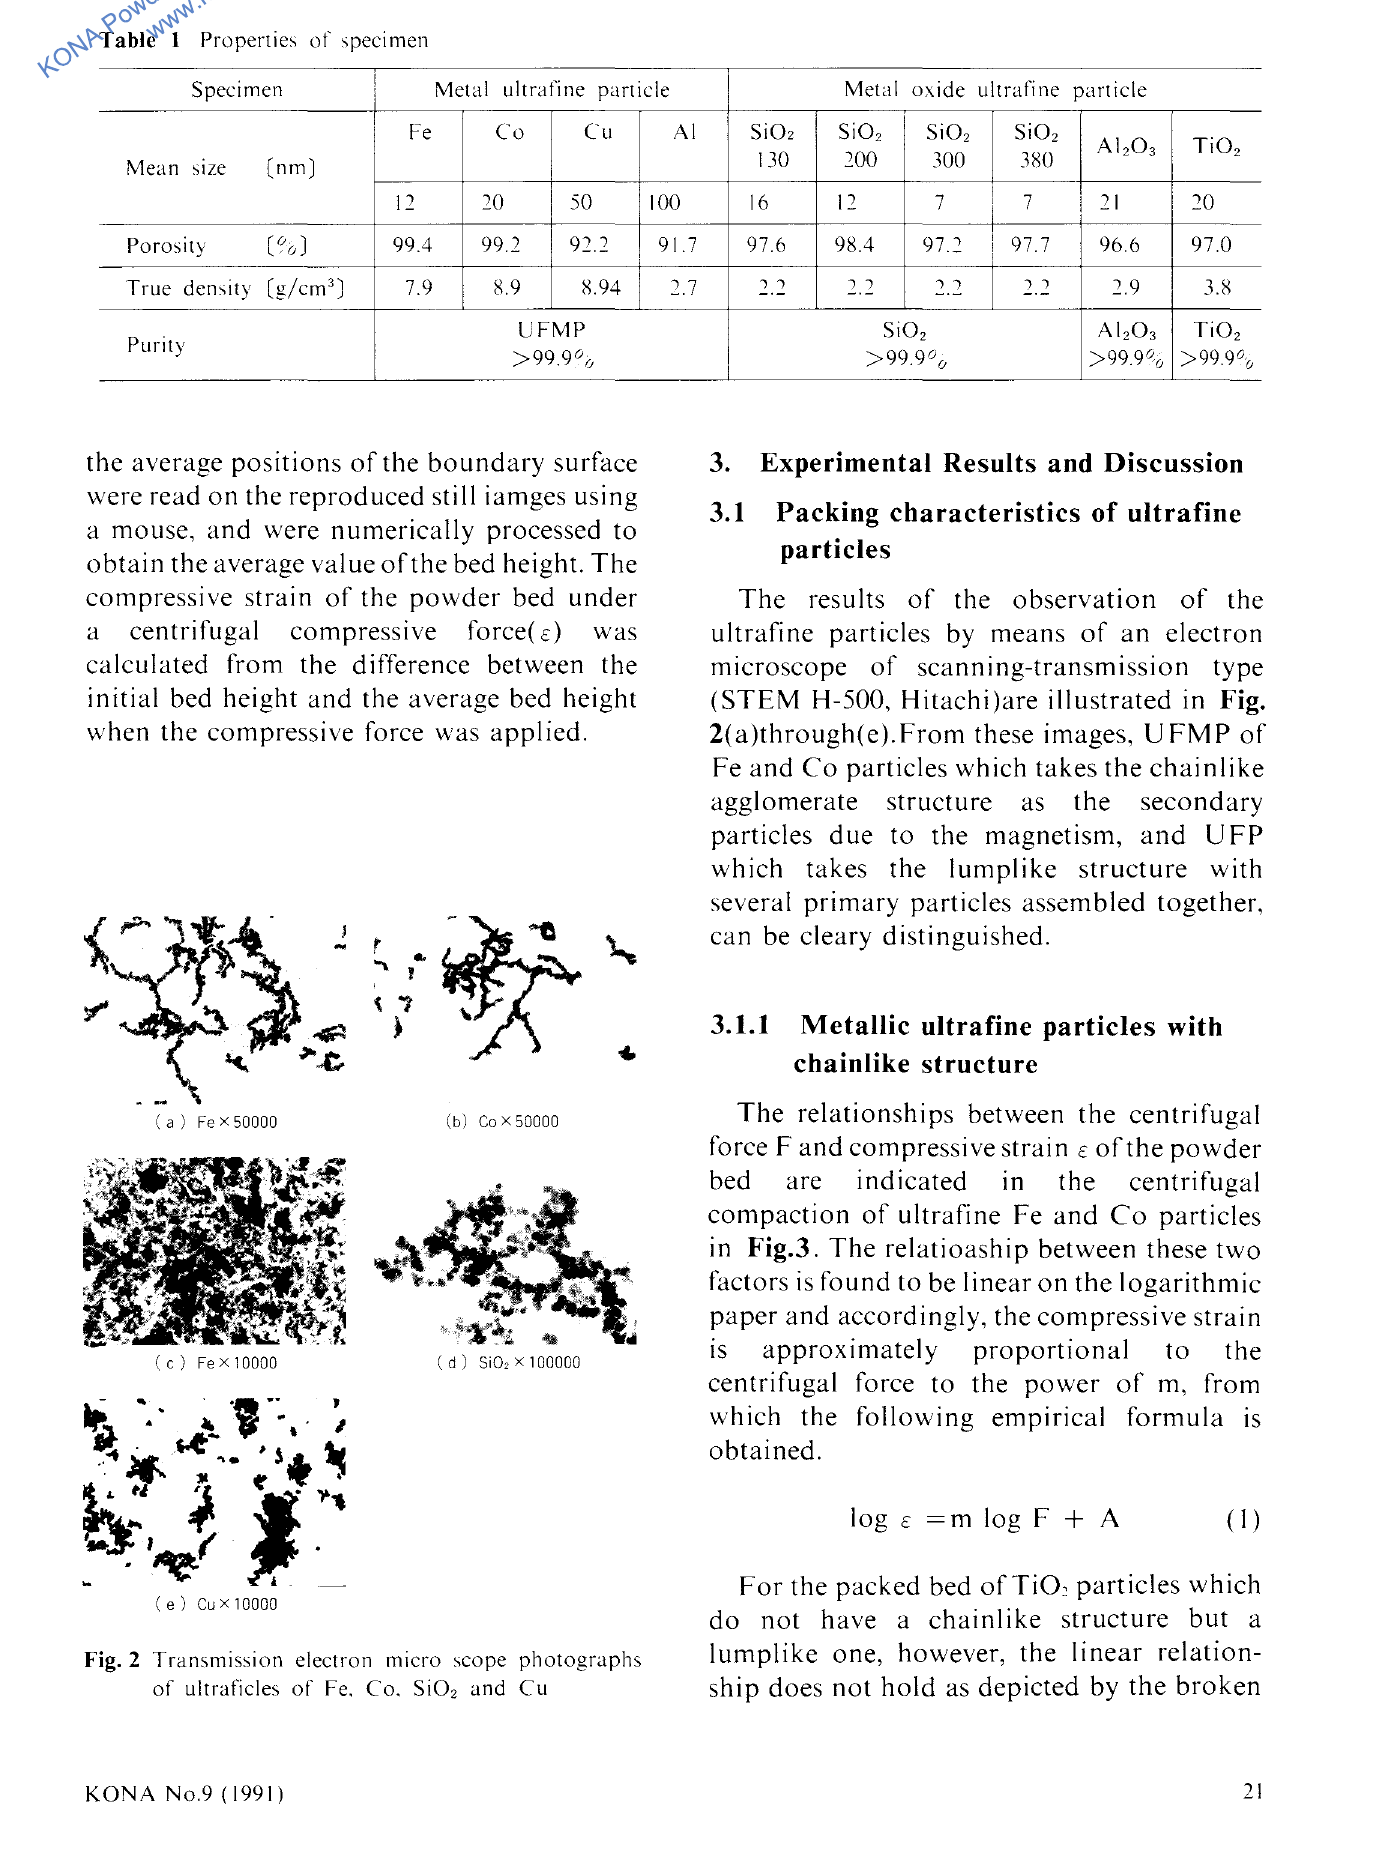
Fig. 2 Transmission electron micro scope photographs of ultraficles of Fe. Co. Si0 2 and Cu